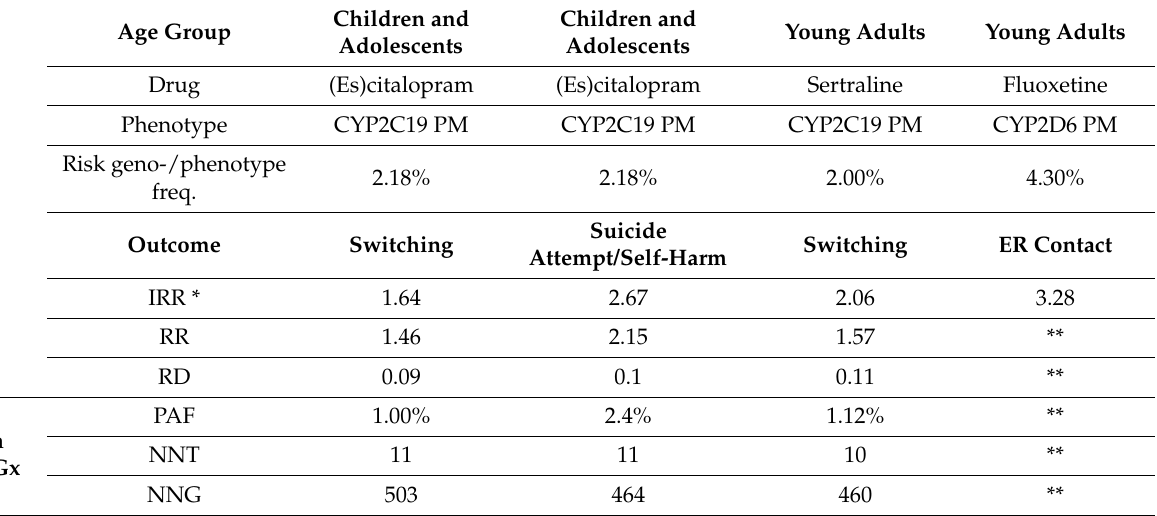
Table 3. Measures of population impact of pharmacogenetic